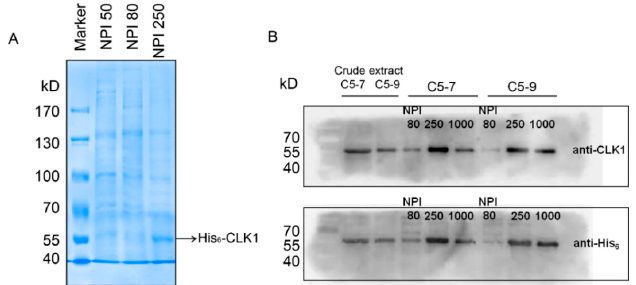
Figure 2. Analysis of CLK1 recombinant protein purified by Ni-NTA column. ( A ) SDS-PAGE and Coomassie staining of purified His 6 -CLK1 by Ni-NTA column after baculovirus-mediated expression in Sf9 insect cells. NPI50, NPI80 and NPI250 represent the increasing concentrations of imidazole in the elution buffer are 50, 80 and 250 mM, respectively. NPI250 shows purified His 6 -CLK1 subsequently eluted from the Ni-NTA affinity column; ( B ) Western Blot analysis of CLK1 and His in crude insect cellular extract and purified His 6 -CLK1 components.